Question: Produce a descriptive caption suitable for publication.
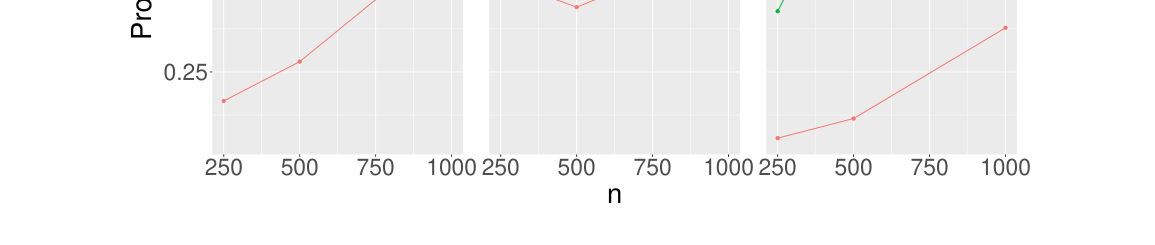
Answer: Simulation for number of initialisations: line plots for PH (the probability of choosing the correct number of hidden nodes), PI (the probability of choosing the correct set of inputs) and PT (the probability of choosing the overall true model) for different values of n and ninit.